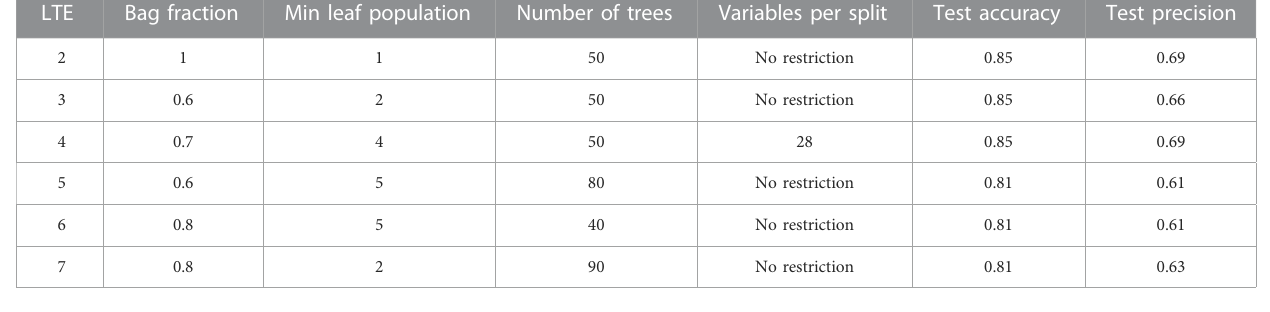
TABLE 2 Reported highest overall accuracy and kappa scores for each LTE model set.